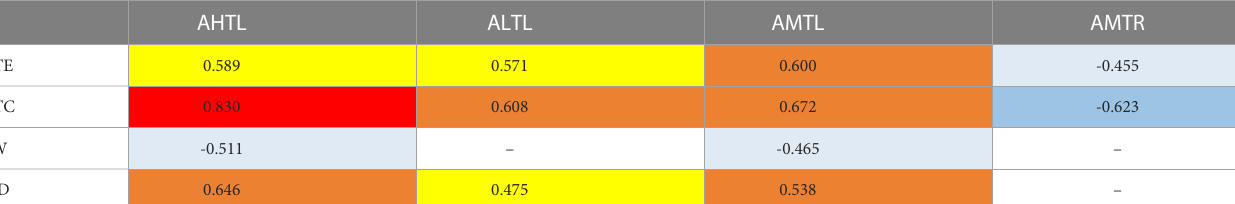
TABLE 3 Correlations between geomorphological variables and tidal level variables. AHTL ALTL